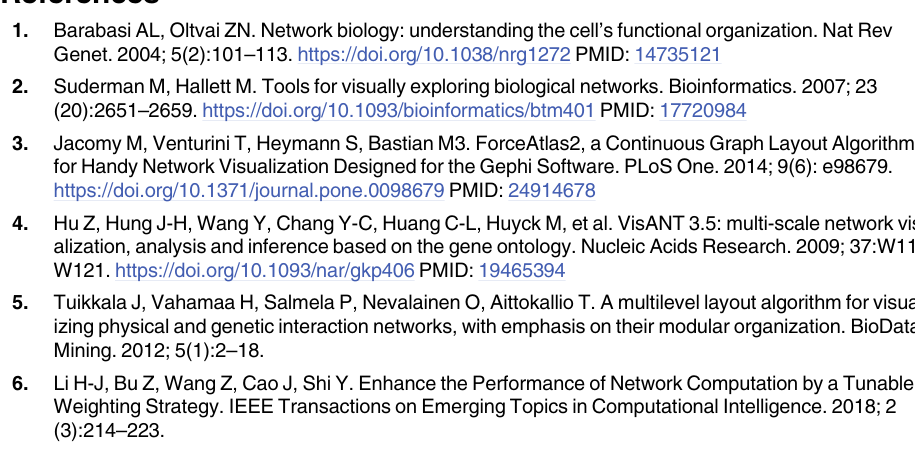
S1 Fig. The layout results of the hybrid layout, GBL and GML algorithms for networks of different size.